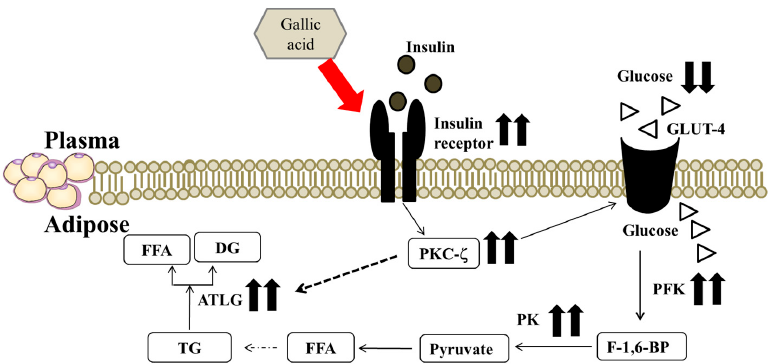
Figure 4. The postulated mechanism for GA to regulate carbohydrate and lipid metabolism via restoring insulin signaling, enhancing glycolysis and lipolysis pathways in perirenal adipocytes of high fructose diet-induced diabetic rats. GA: gallic acid; FFA: free fatty acid; DG: diglyceride; ATGL: adipose triglyceride lipase; TG: triglyceride; PKC- ζ : protein kinase C-zeta; PK: pyruvate kinase; GLUT-4: glucose transporter 4; PFK: phosphofructokinase; F-1,6-BP: fructose 1,6 biphosphate. Oral administration of GA at a dose of 500 mg/kg was demonstrated to cause no toxicity or mortality in mice. GA is non-toxic at an acute dose of 5000 mg/kg body weight; this dose is recognized as no-observed-adverse-effect level (NOAEL) for GA in mice. A subacute administration of 1000